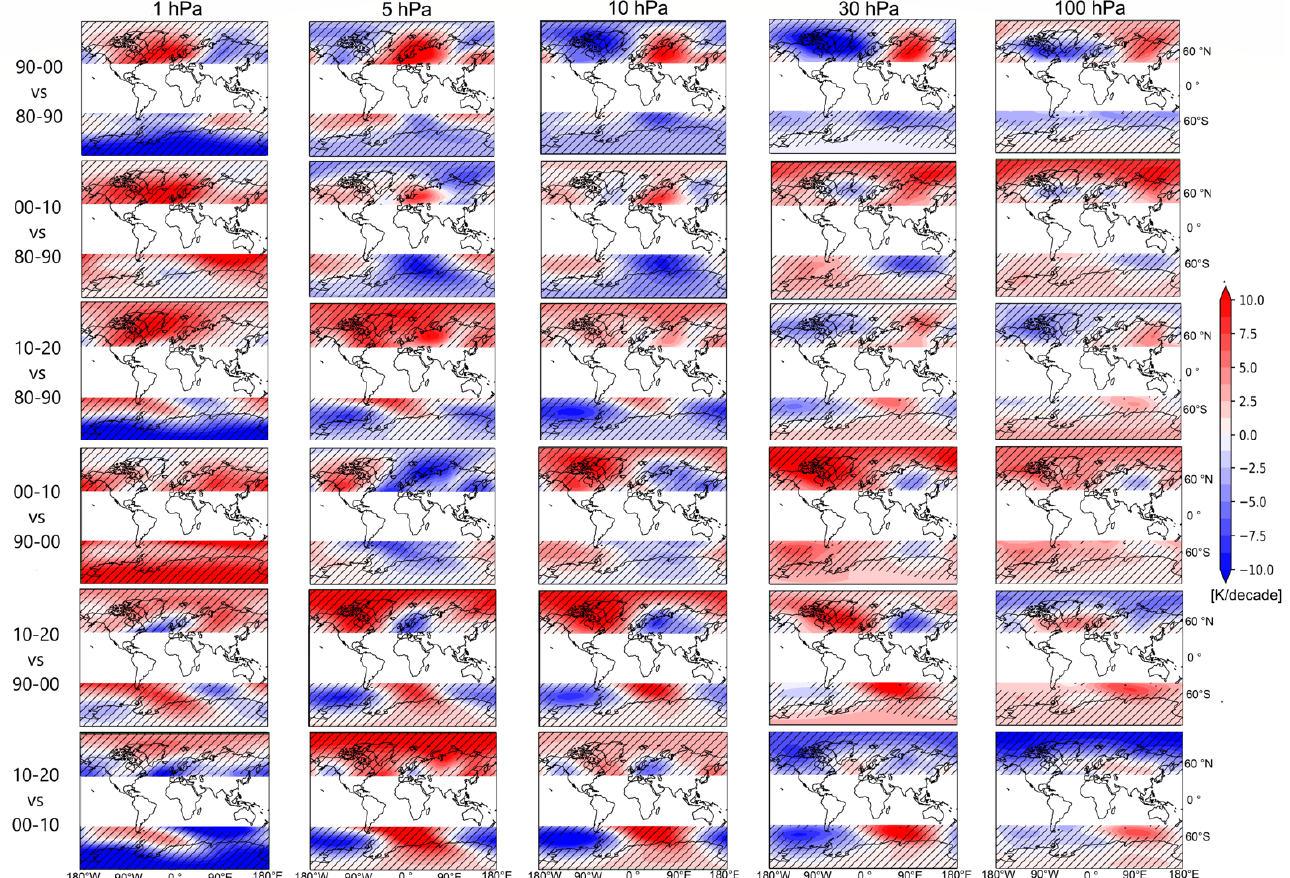
Figure 5. Difference of temperature trend (K) between decades for 1, 5, 10, 30 and 100 hPa using ERA5 reanalysis.